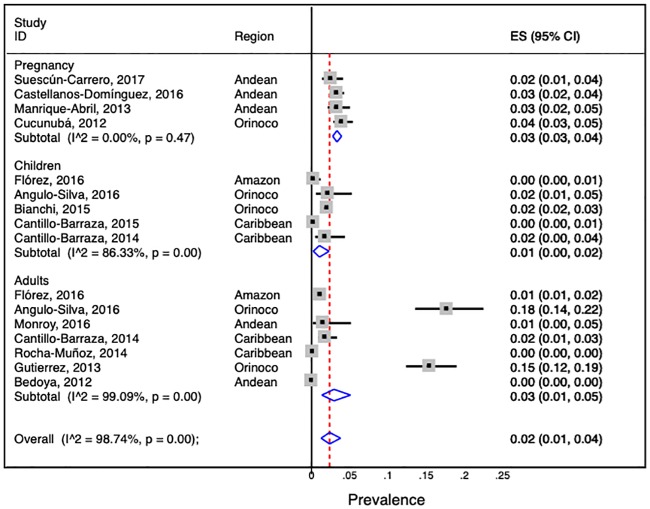
Forest plot showing the meta-analysis of population-based prevalence of Chagas disease in Colombia.